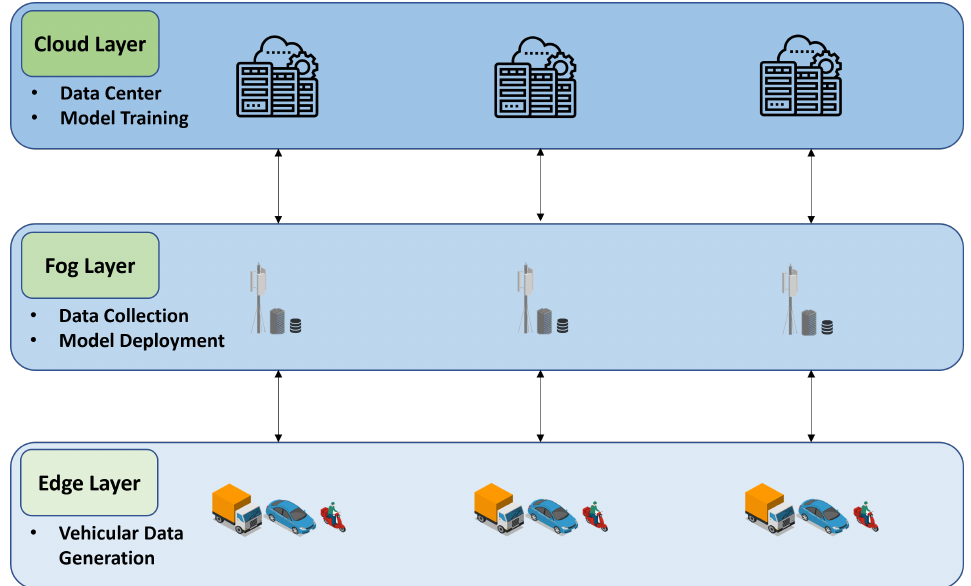
Figure 1. Systems hierarchical